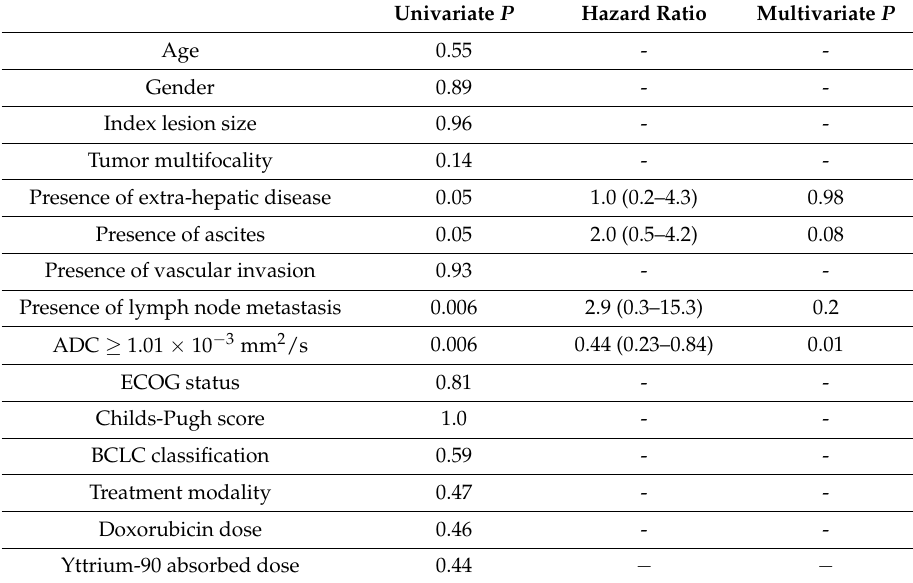
Figure 1. A solitary hepatocellular carcinoma (HCC) lesion with relatively homogenous arterial enhancement was found to have heterogeneous apparent diffusion coefficient (ADC) signal intensity on pre-procedure imaging. In particular, the medial aspect of the lesion was hypointense relative to the lateral aspect (red asterisk). The first post-procedure imaging study at 2 months demonstrated a small area of residual tumor in the portion of the tumor noted to have low ADC values. At 4 months, there was progression of disease in this same location. Table 3. Univariate and multivariate analysis of demographic and imaging covariates for index lesion specific progression free survival (PFS). On multivariate analysis, ADC was the only covariate identified that correlated with